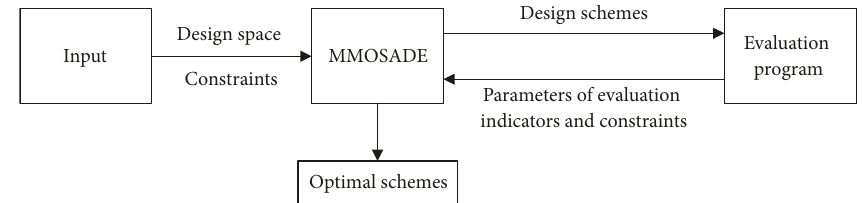
Figure 3: Diagram of nuclear power system multiobjective optimization design platform.